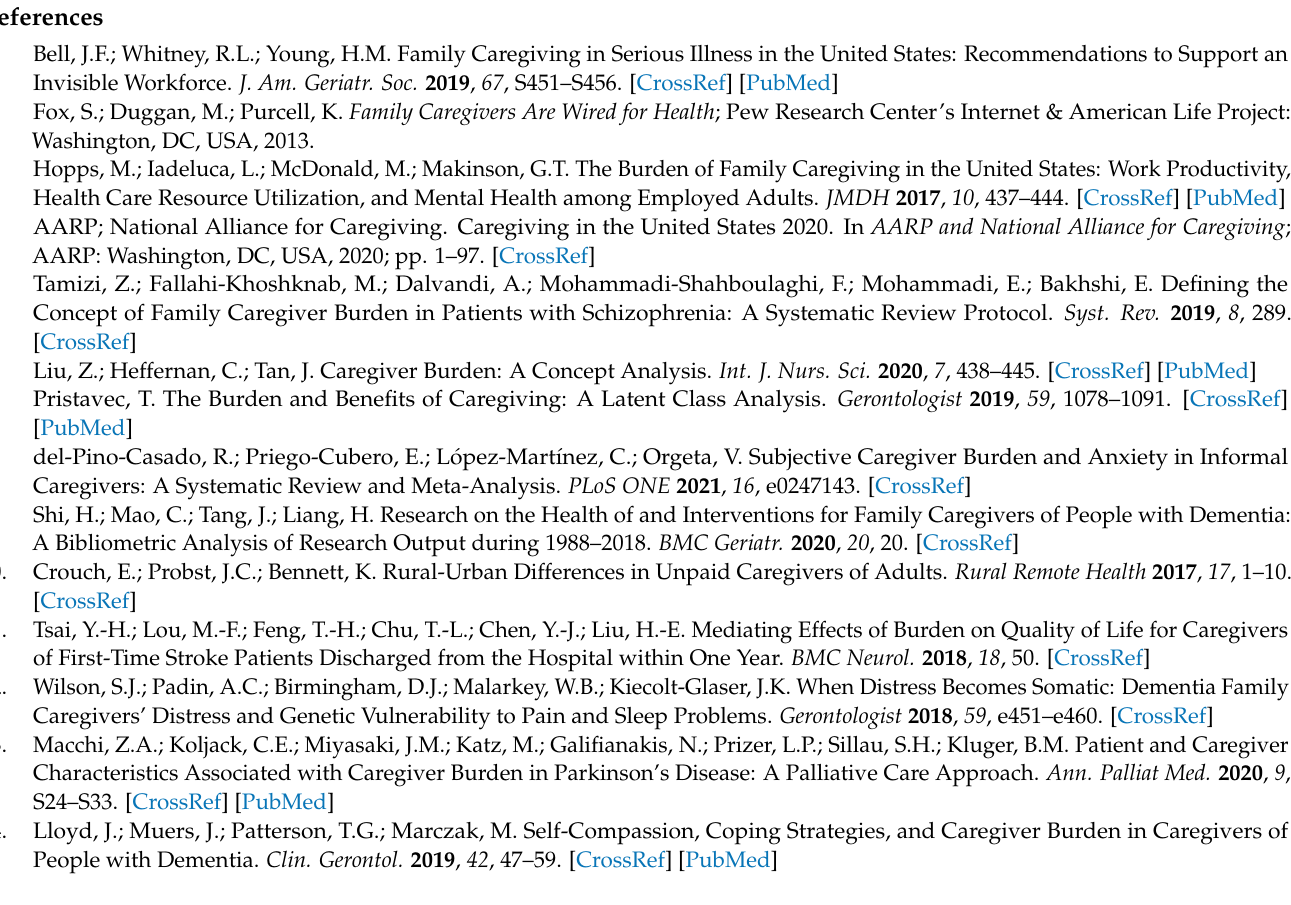
Figure A2. PyLDAvis interactive viz showing term frequency within corpus and topics. Topic themes are represented as circles number 1—10 and clicking on the numbered circle provides the most common terms within the topic cluster. Adjusting the lambda bar in the upper right corner providers the reviewer with the most common words in the cluster and the most common words in the cluster that are not found in the corpus.